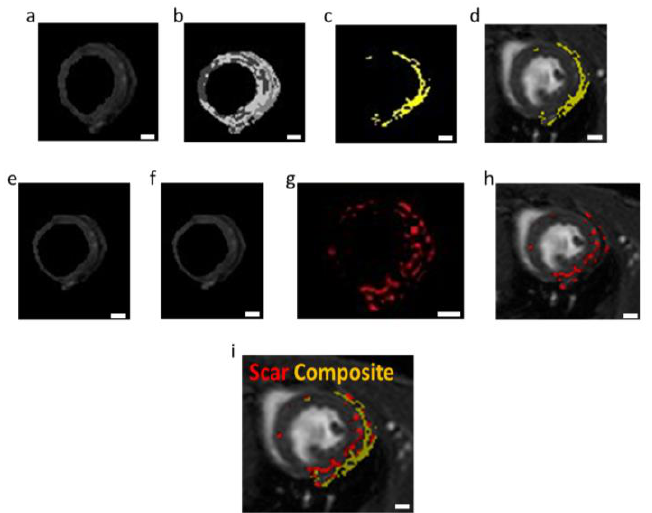
Figure 7. Imaging the coverage area of the treatment in relation to scar area. ( a – d ) Segmentation process for detection of the Gd-AuNP nanocomposite hydrogel (yellow). ( a ) LV wall in MRI imaging. ( b ) K-means algorithm, k = 4. ( c ) The location of the Gd-AuNPs composite hydrogel as detected by the algorithm. ( d ) Final MRI image with the location of the hydrogel. ( e – h ) Subtraction process for detection of the scar tissue (red). ( e ) LV wall post systemic injection of Gd. ( f ) LV wall before systemic injection of Gd. ( g ) Subtraction MRI image. ( h ) Final MRI image with the location of the scar tissue after noise filtering. ( i ) Merged image of ( d , h ). The nanocomposite hydrogel (yellow) with respect to the scar tissue (red), 45 min post systemic injection of Gd-DTPA solution; scale bars = 1 mm.